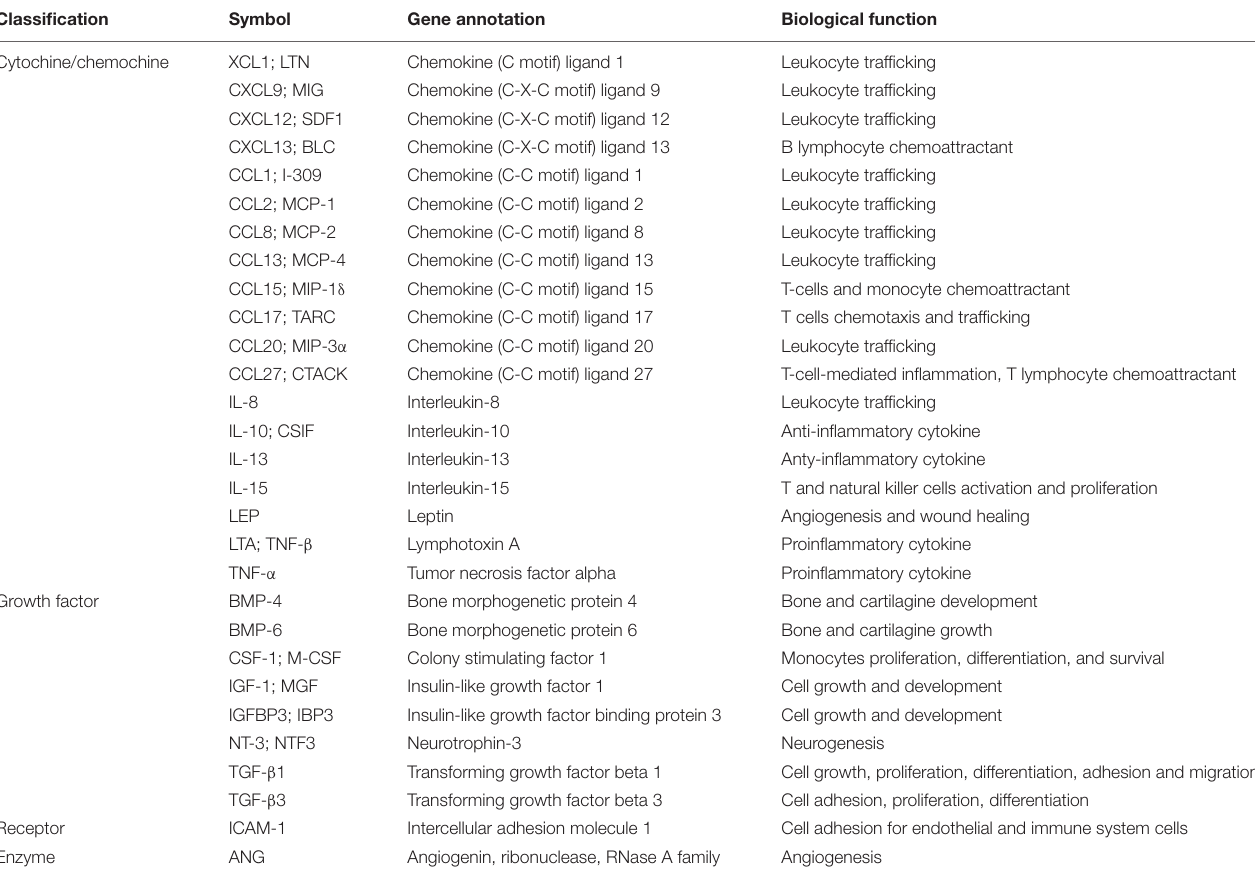
TABLE 2 | Main bioactive proteins assessed in the HCMV secretome of latently infected CD34 + cells. Classification Symbol Gene annotation Biological function